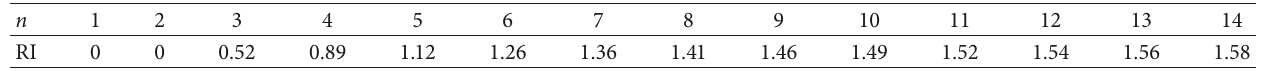
Table 3: Average random consistency